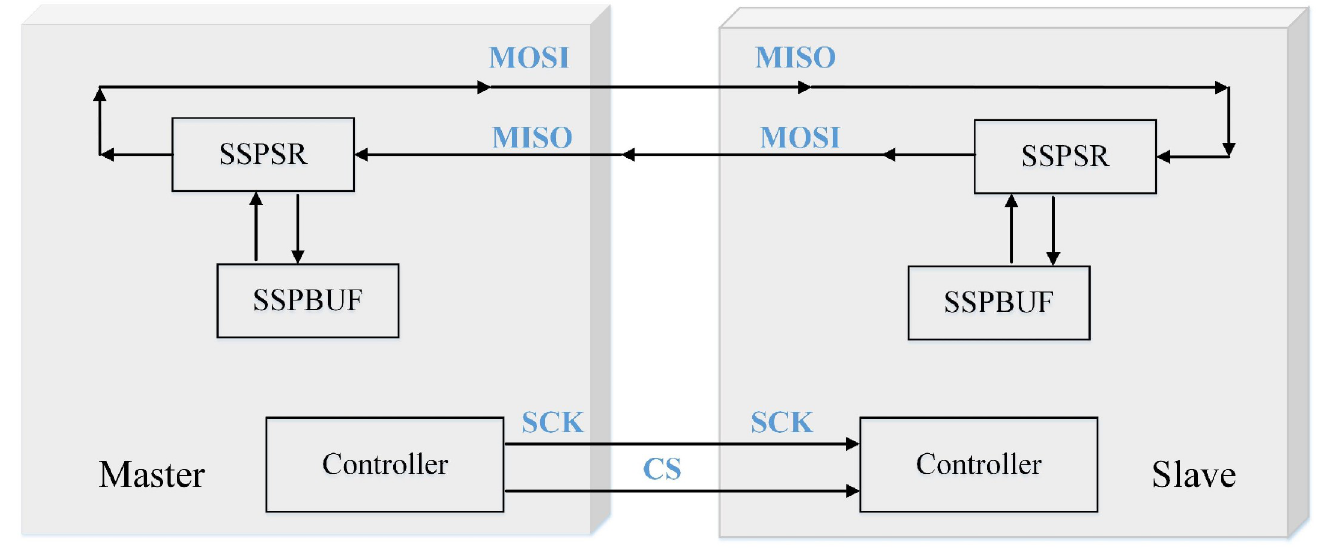
Fig 5. SPI communication